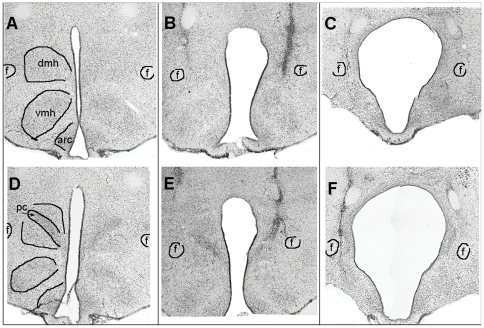
Digital images of 40 µm cresyl violet stained coronal brain sections through the hypothalamus at two levels of the dorsomedial hypothalamic nucleus (DMH).A–C: ∼2.9 mm posterior to bregma (Paxinos and Watson, 2009). D–F: ∼3.24 mm posterior to bregma. (A,D). An intact rat. (B,E). A rat sustaining minor (<20%) DMH damage. (E,F). The rat sustaining the largest lesion, with complete ablation of the DMH, including the DMH pars compacta (PC), and partial damage to the ventromedial hypothalamic nucleus (VMH) and the arcuate nucleus (ARC).